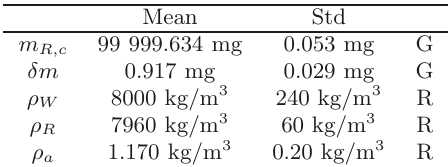
Fig. 6. Histogram associated with the MCM sample for the mass calibration example and a Gaussian with the same mean and standard deviation as the sample. Table 1. Uncertainty data for mass calibration